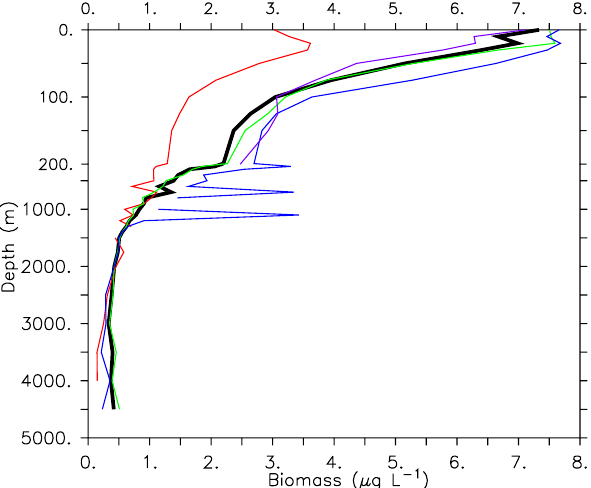
Figure 3. Picoheterotroph biomass averaged over all available lon- gitudes, latitudes and months, as a function of depth, (black line) global average, (blue line) tropical oceans, (green line) temperate regions, (red line) polar oceans, (purple line) coastal ocean abun- dance × open ocean conversion factor.